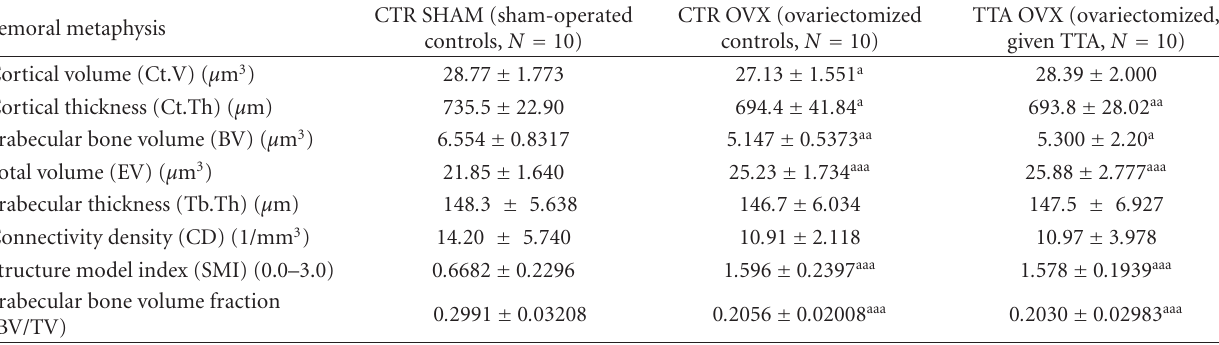
Table 6: Mean values ± SD of bone architecture parameters in the femoral metaphysis, determined by means of μ CT scanning analyses in sham controls, ovariectomized controls, and ovariectomized rats fed TTA for four months (Study II).